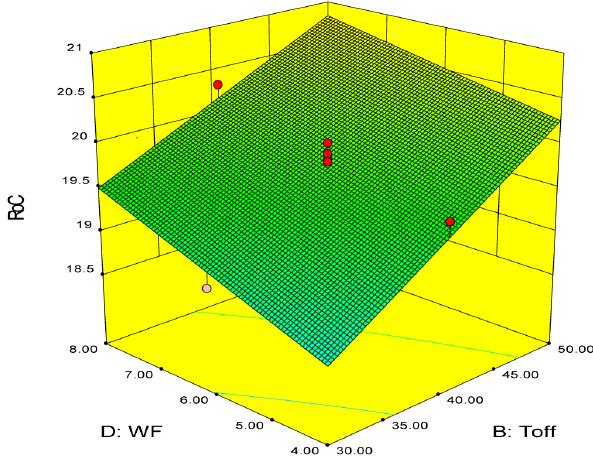
Figure 8d. Combined e ff ects of WF and T o ff on